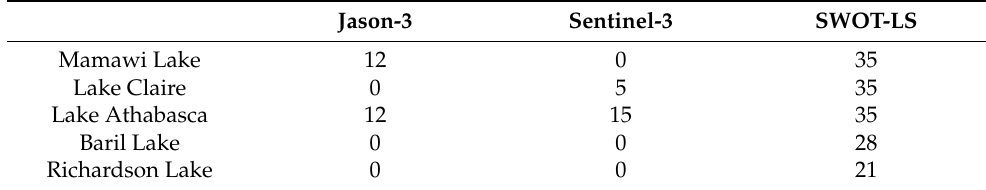
Figure 7. 2020 water surface area comparison between June and August for Sentinel-1 (S1), Sentinel- 2 (S2) and Landsat-8 (LS8) where grey shows area of open water seen at both dates, blue shows open